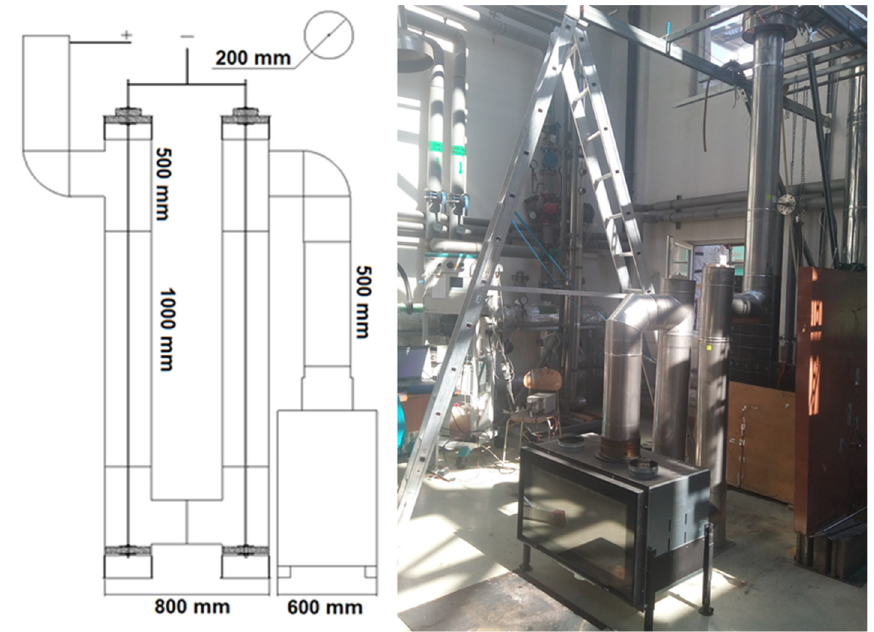
Figure 1. The combustion device with the optimized electrostatic